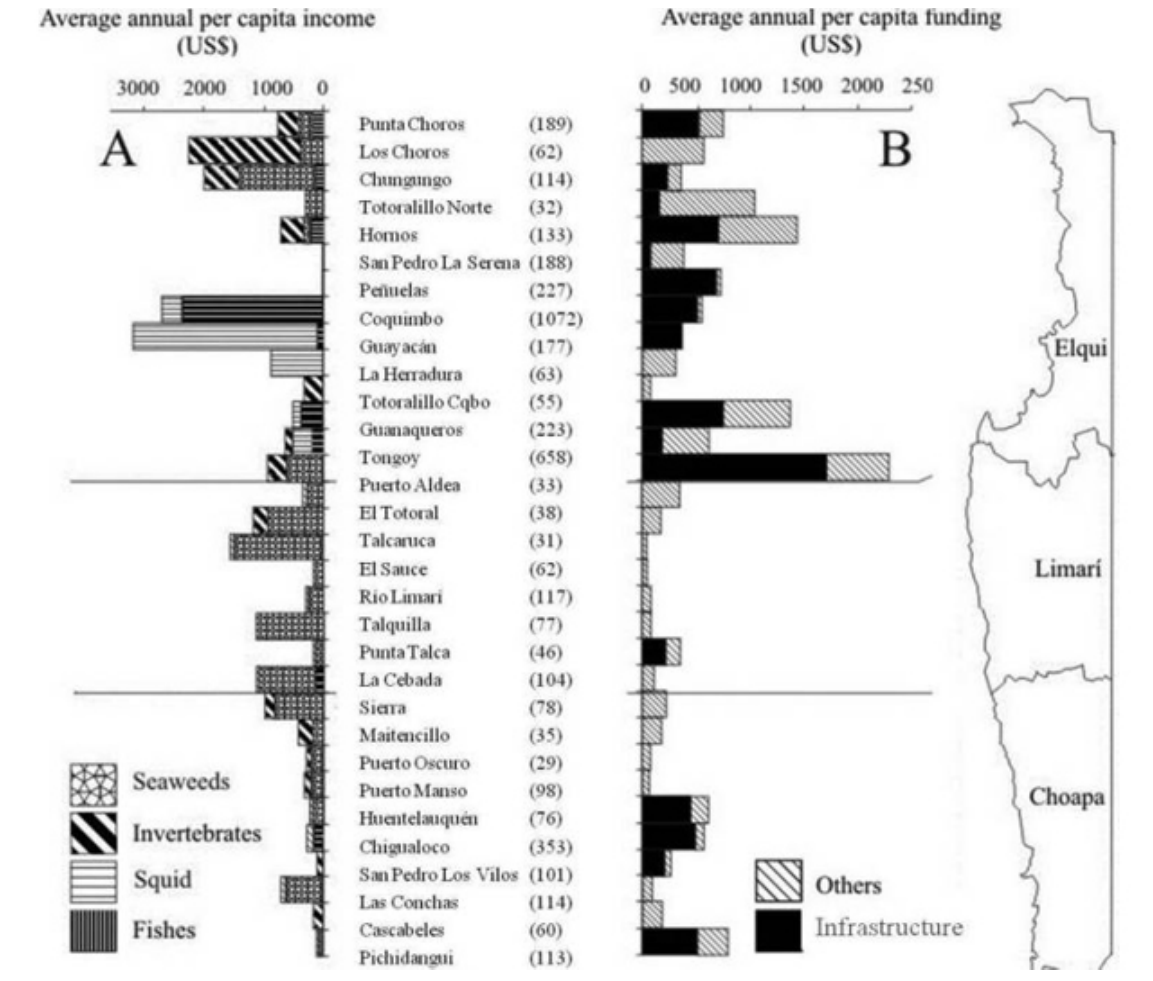
Fig. 3 . Distribution of average annual per capita income (A) and of average annual per capita funding (B) for each of the caletas in Coquimbo Region during 10 years in the period 1996–2007. Income (A) is separated into the resource group producing it, and funding (B) is separated by funding line. In brackets, the number of fishers for each caleta is